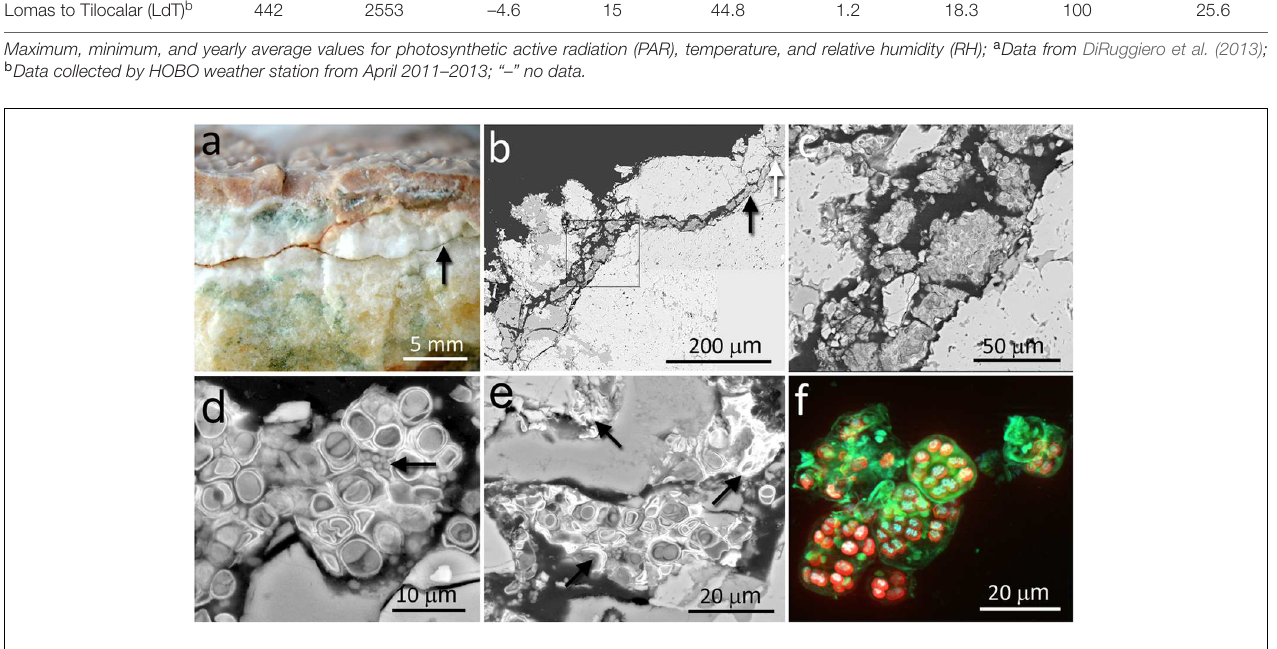
Frontiers in Microbiology |